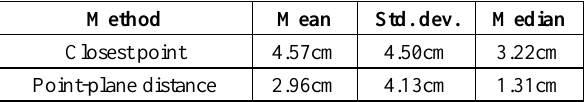
Table 7. Accuracy assessment results using the GNSS global coordinate system and based on distance comparison method.